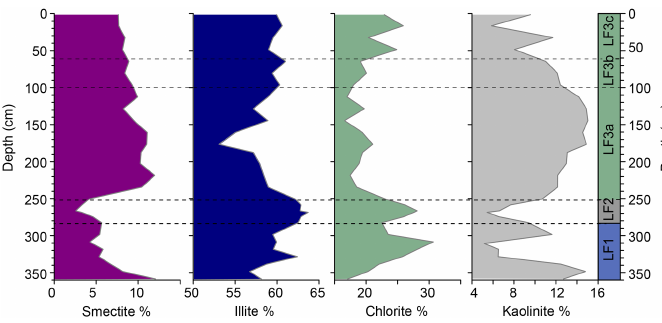
Figure 7. Clay mineral data for LC12. Horizontal (dashed) lines delineate the main lithofacies (LF) 1–3.